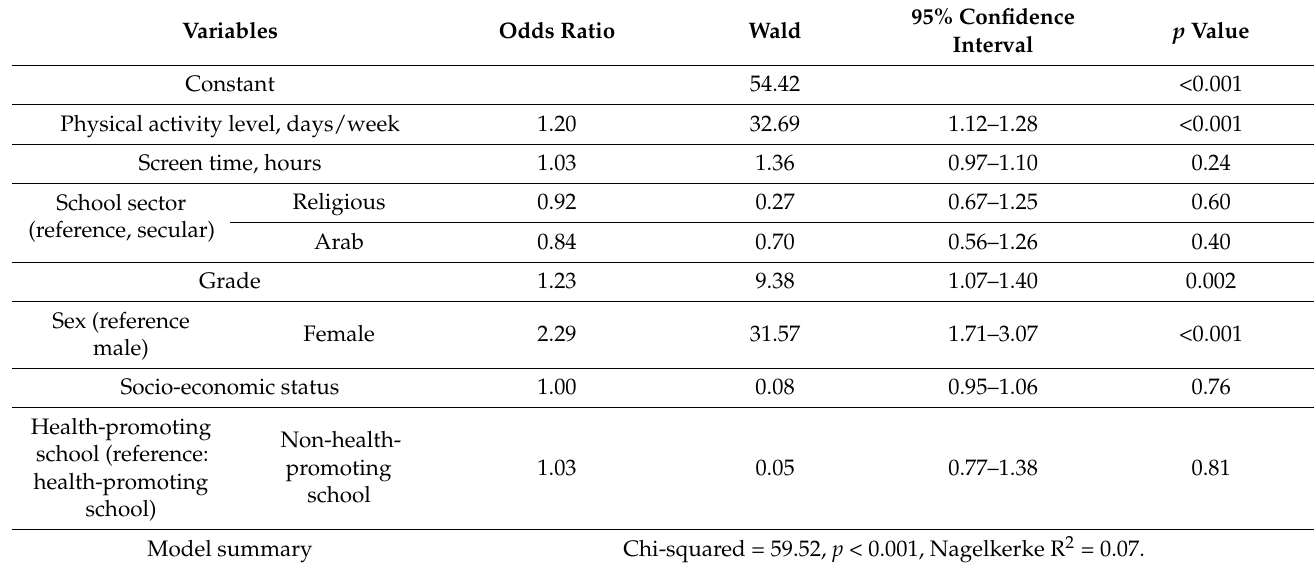
Table 6. Summary of multiple binary logistic regression analysis: dieting